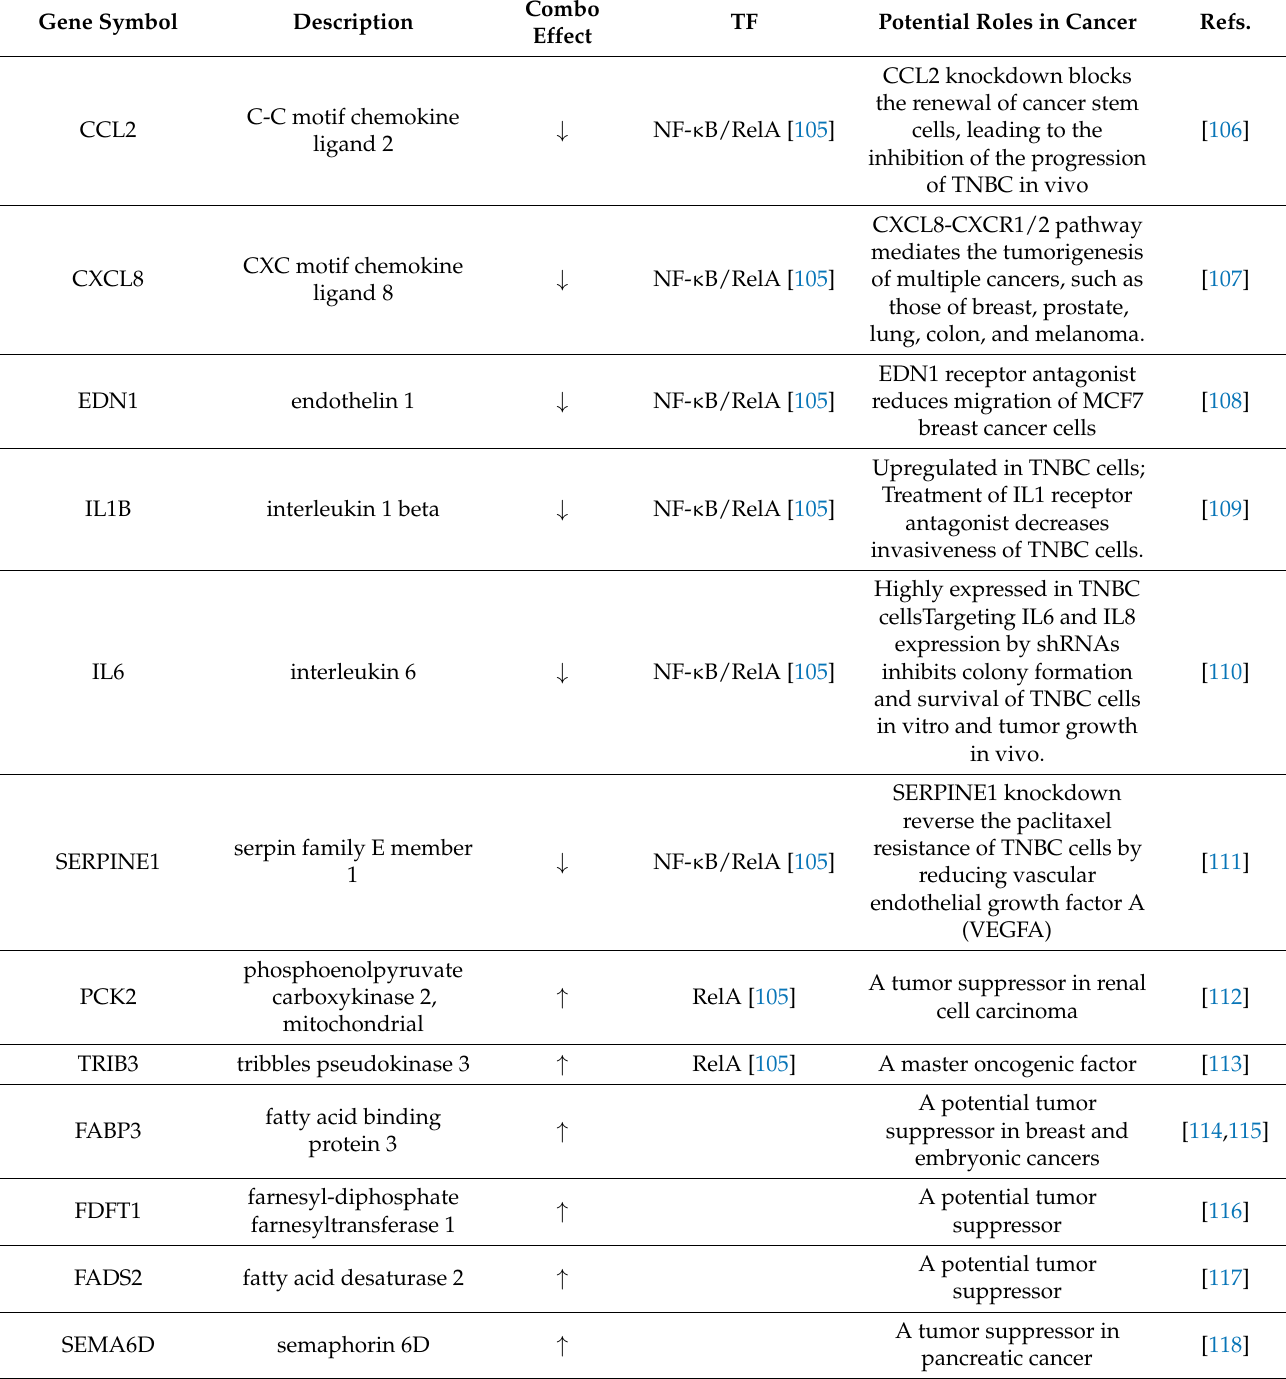
Table 2. Potential roles of selected genes from transcriptome analysis. ↑ upregulate; ↓ downregulate. Gene